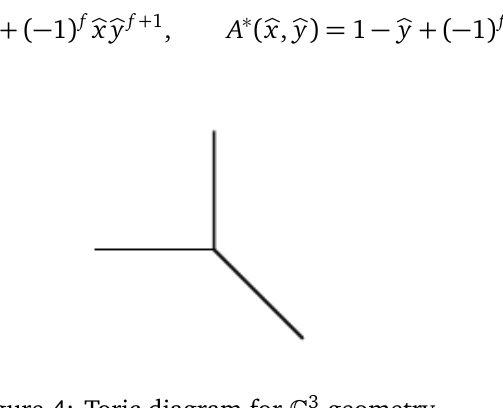
Figure 4: Toric diagram for (cid:67) 3